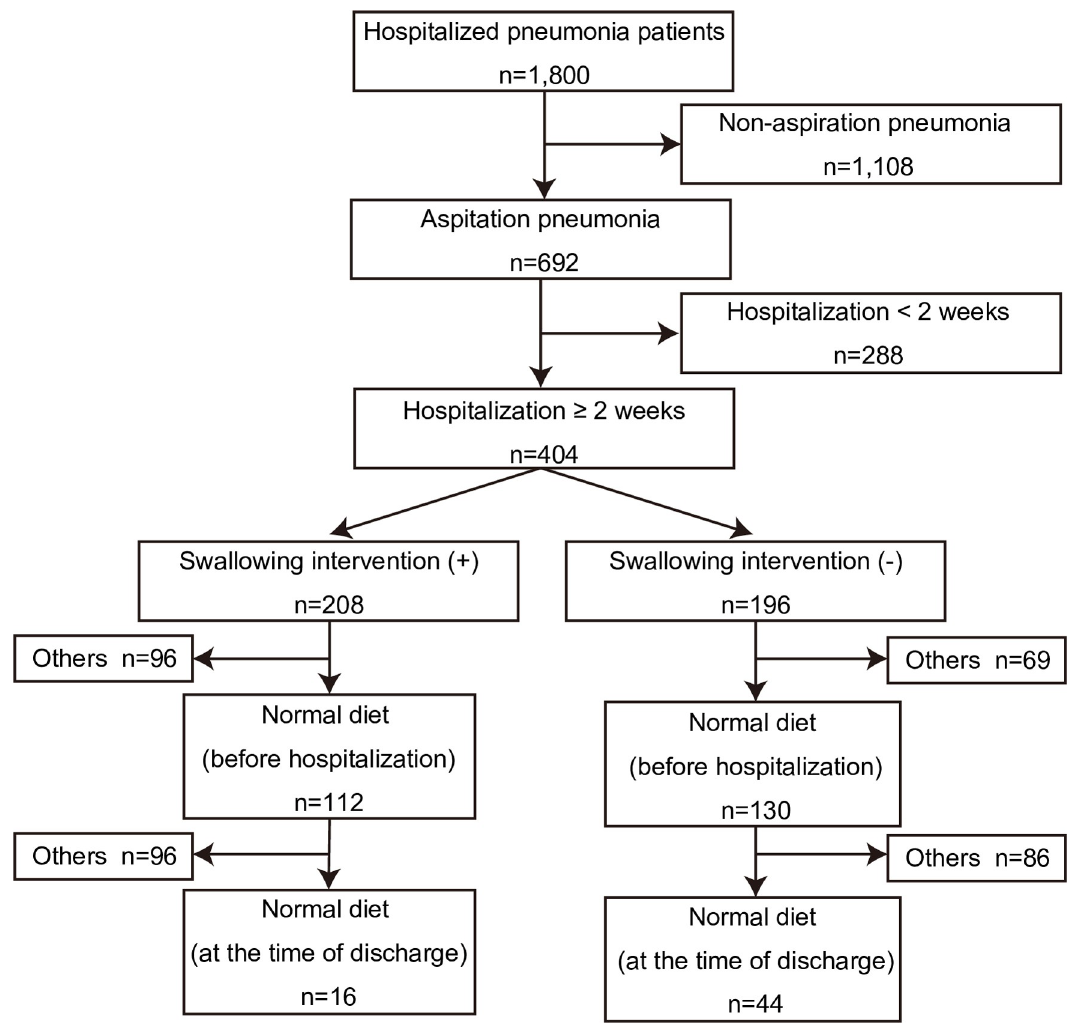
Fig 2. A flow chart of patients evaluated throughout the course of this